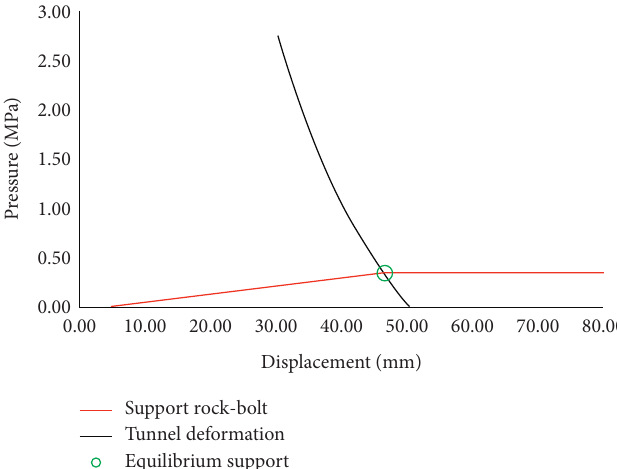
Figure 7: Rock-support interaction curve for the tunnel using optimal support parameters.